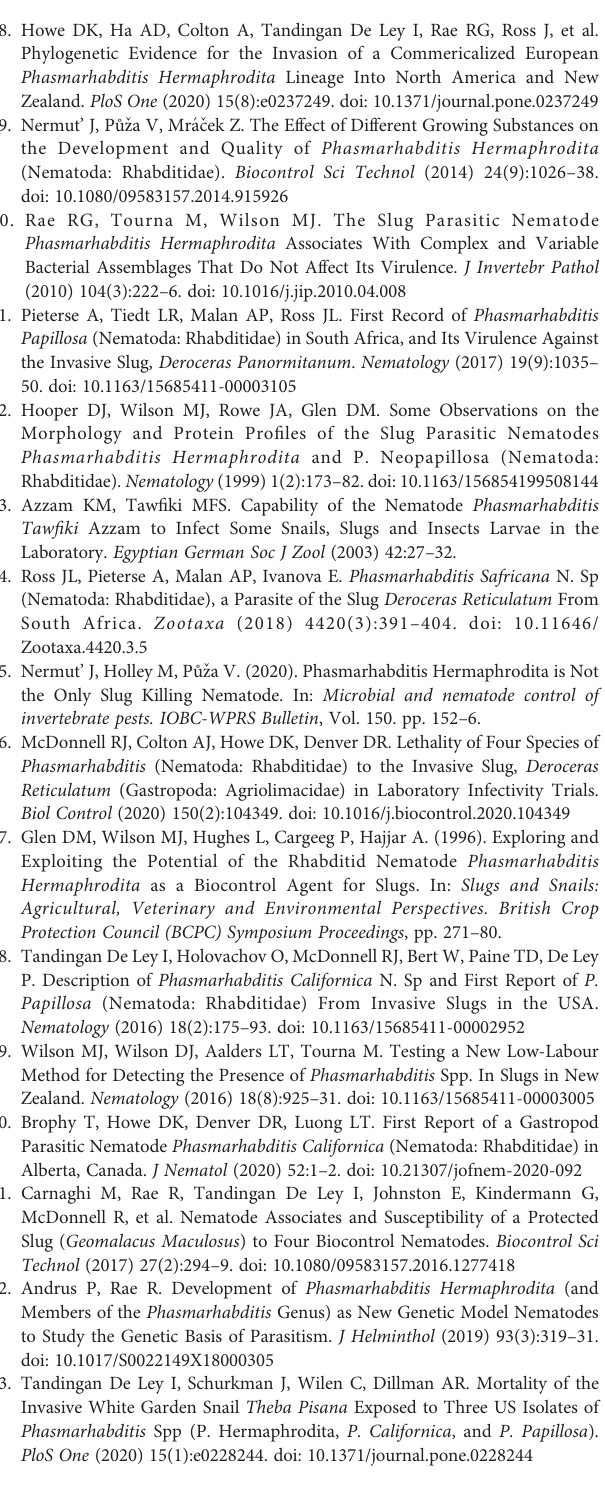
Supplementary Figure 2 | Alignment of M. osloensis , P. faecaelis and consensus sequence of the bacteria originally thought to be M. osloensis .